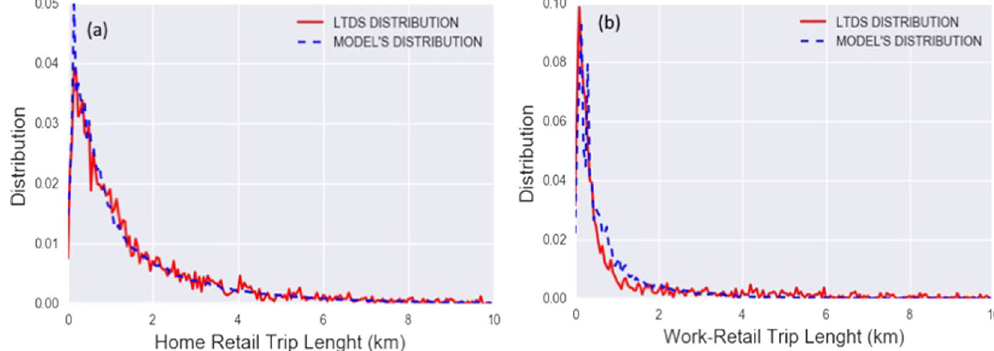
Figure 1. We show the maximum likelihood modeled distributions and the observed ones. For home-retail trips in ( a ) β h = 0.25 and λ h = 0.3, while for work-retail trips in ( b ) we have found β w = 0.35 and λ w = 0.25. As we can see from the figures in both cases the parameters that maximize the likelihood generate a distribution that fits the observed one very